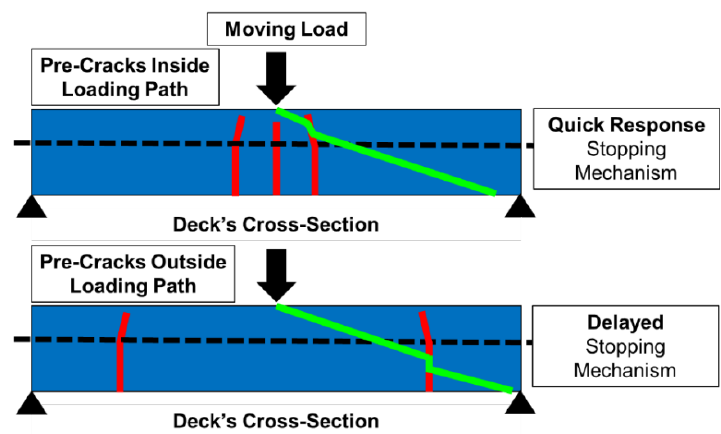
Figure 20. Pre-cracks stopping mechanism inside and outside loading path.